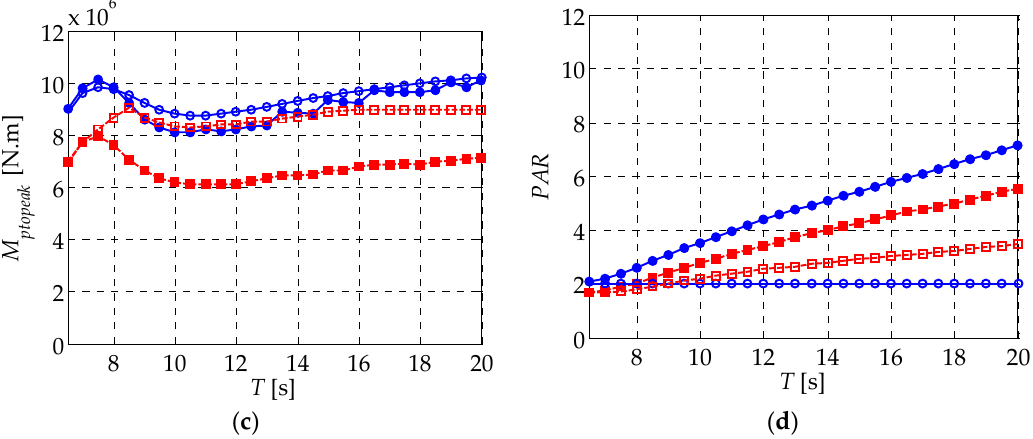
Figure 9. Duck WEC performance comparison between latching and resistive control when relative capture width is maximized for different load types: ( a ) maximum relative capture width; ( b ) peak motion excursion; ( c ) peak PTO moment; ( d ) peak-to-average power ratio. Table 1. Magnification factor of the WEC performance under latching control compared to that under resistive control, averaged over the wave period set T wl = {8, 8.5, 9, …, 20}. WEC Performance